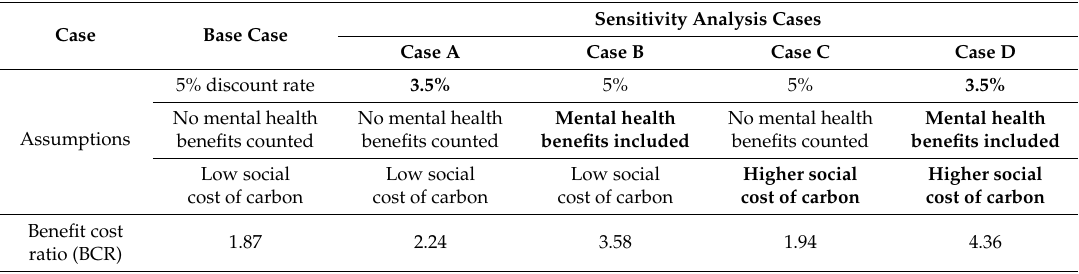
Table 1. How the benefit cost ratio varies depending on critical assumptions (sensitivity analysis of the insulation